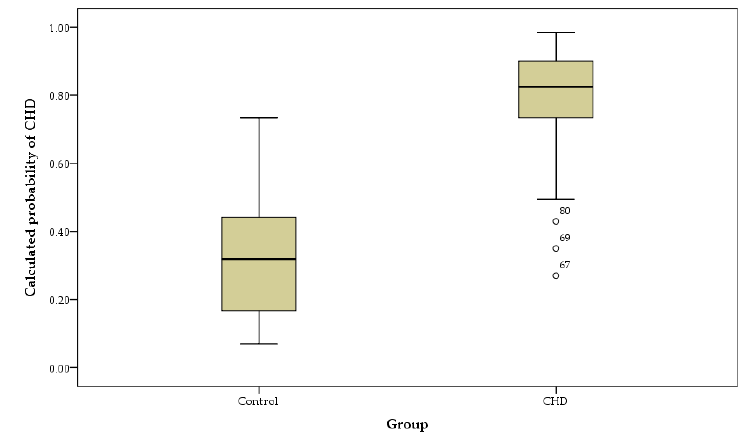
Figure 1. The ROC curve of the classification model for CHD.